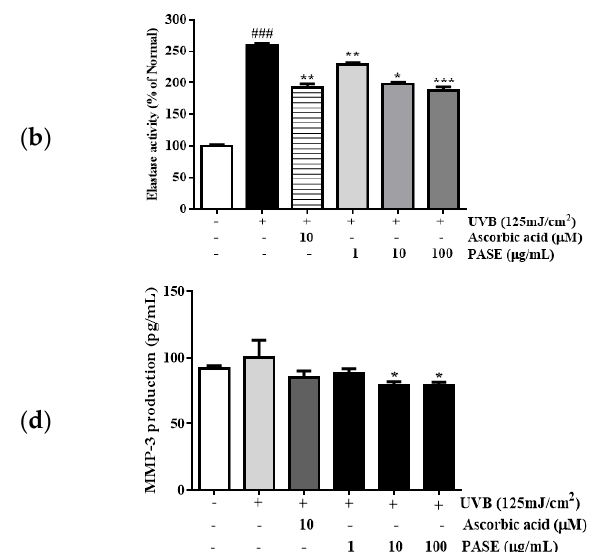
Figure 4. PASE inhibited the secretion of collagenase, elastase, MMP-1, and MMP-3 in UVB-exposed HaCaT cells: Collagenase ( a ), elastase ( b ), MMP-1 ( c ), and MMP-3 ( d ) secretion by UVB-exposed HaCaT cells. Data are shown as means ± SDs of three independent experiments. ## p < 0.01, ### p < 0.001 compared with non-exposed group, * p < 0.05, ** p < 0.01, *** p < 0.001 compared with only UVB-exposed group.